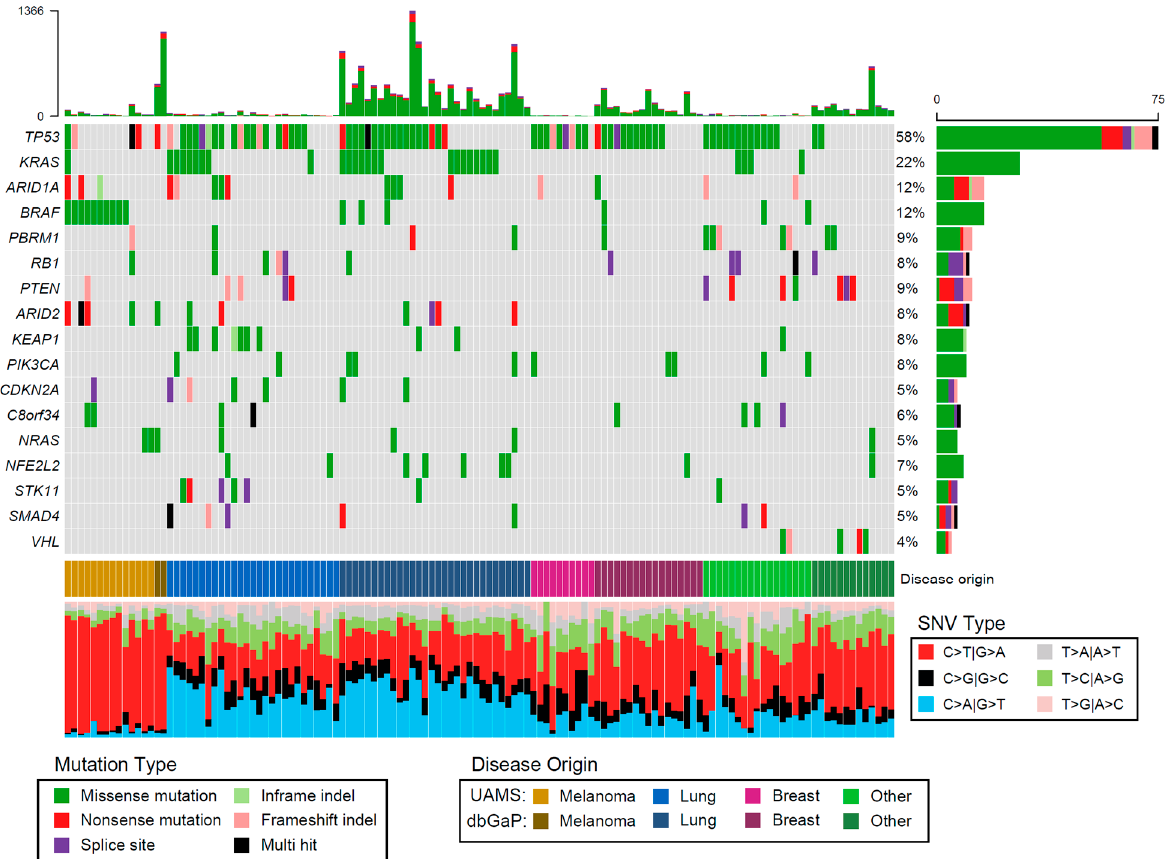
Figure 1. Oncoplot of frequently mutated genes in BM. The 17 significantly mutated genes were selected, and ordered by their overall frequency. Each column represents a single sample and each row a gene, with samples grouped by subtype. The barplot above and to the right represent the total number of deleterious mutations in each sample and the type of mutations detected in each gene, respectively. The stacked barplot at the bottom shows the contributions of each of the 6 mutation classes in each sample.